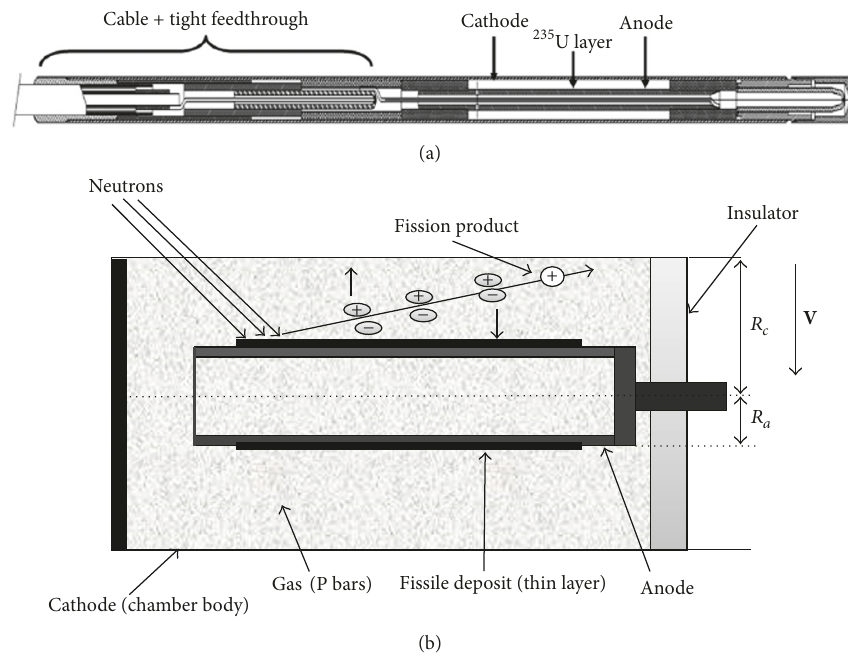
Figure 1: (a) Overall plan of FC with fissile element 235 U [12] and (b) simplified schema of cylindrical FC [13].